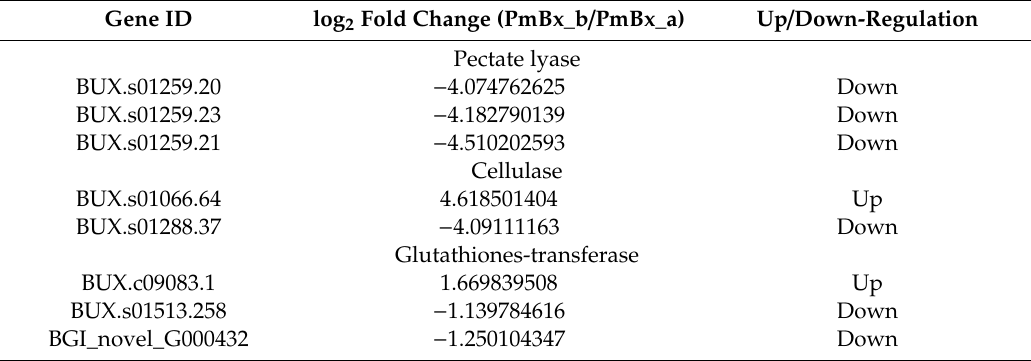
Table 5. Di ff erentially expressed genes associated with virulence of B. xylophilus in P. massoniana inoculated with B. xylophilus alone (PmBx_a), or B. xylophilus with S. maltophilia